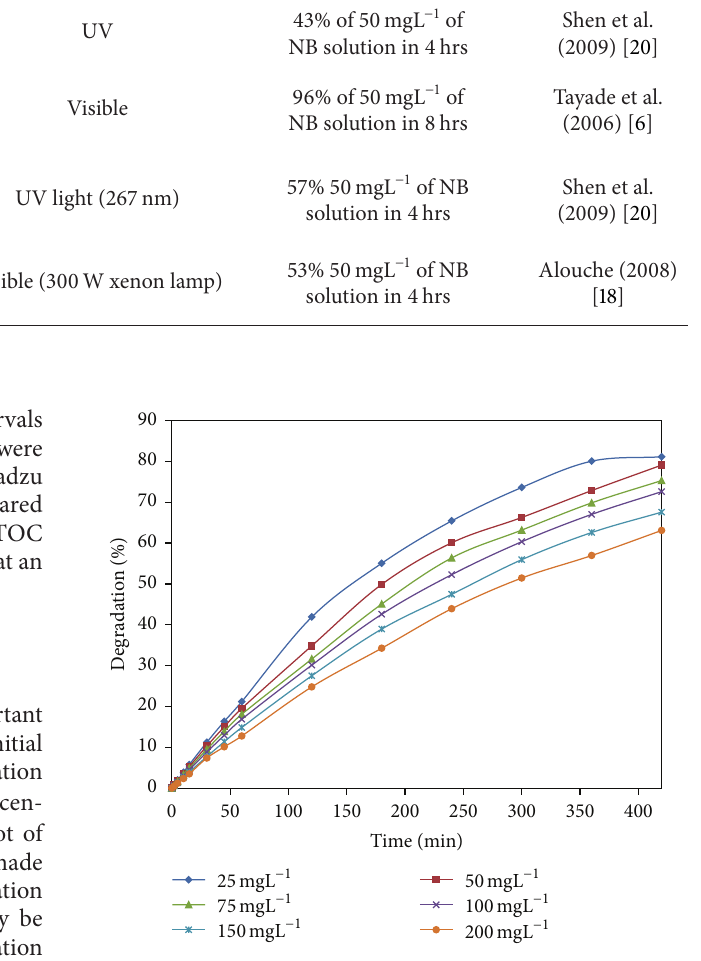
Figure 7: Effect of solution concentration on degradation % (light intensity: 500W, pH: 6.8, and catalyst dosage: 0.1g L −1